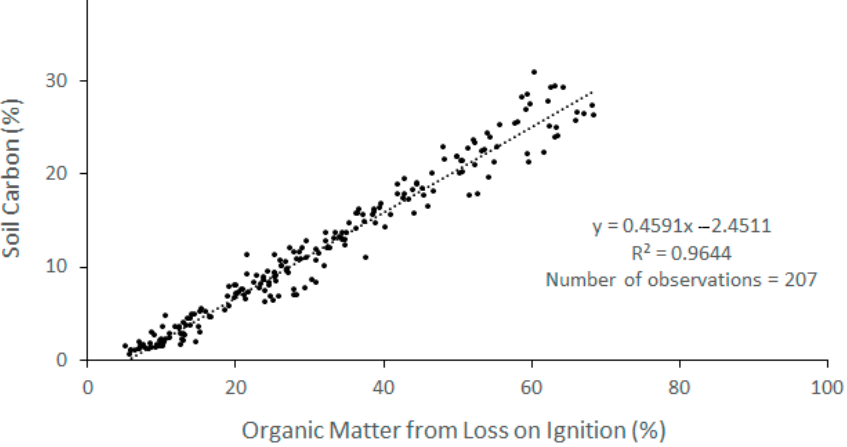
Figure 2. Relationship between organic matter (%) and the soil organic carbon concentration (%) in the mangrove soil. Samples from all sampling sites and soil depth from 1 m upwards were used.